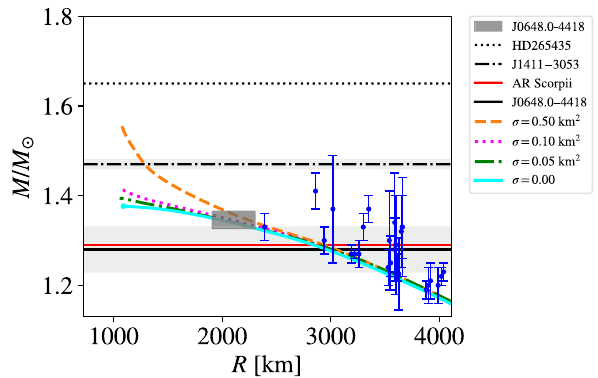
Fig. 4 Same as Fig. 1, but considering the 20 Ne threshold for equation of